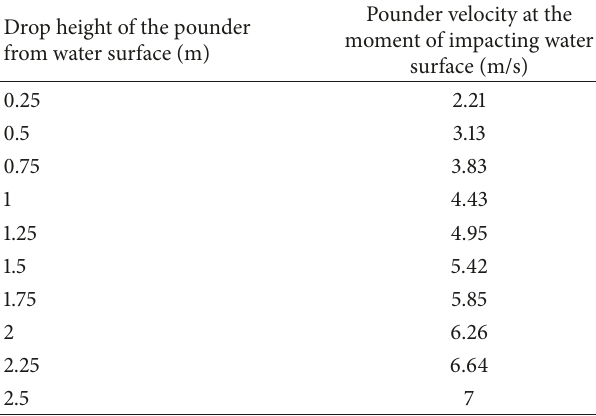
Table 4: Velocity of the conical pounder with different drop heights at the moment of impacting the water